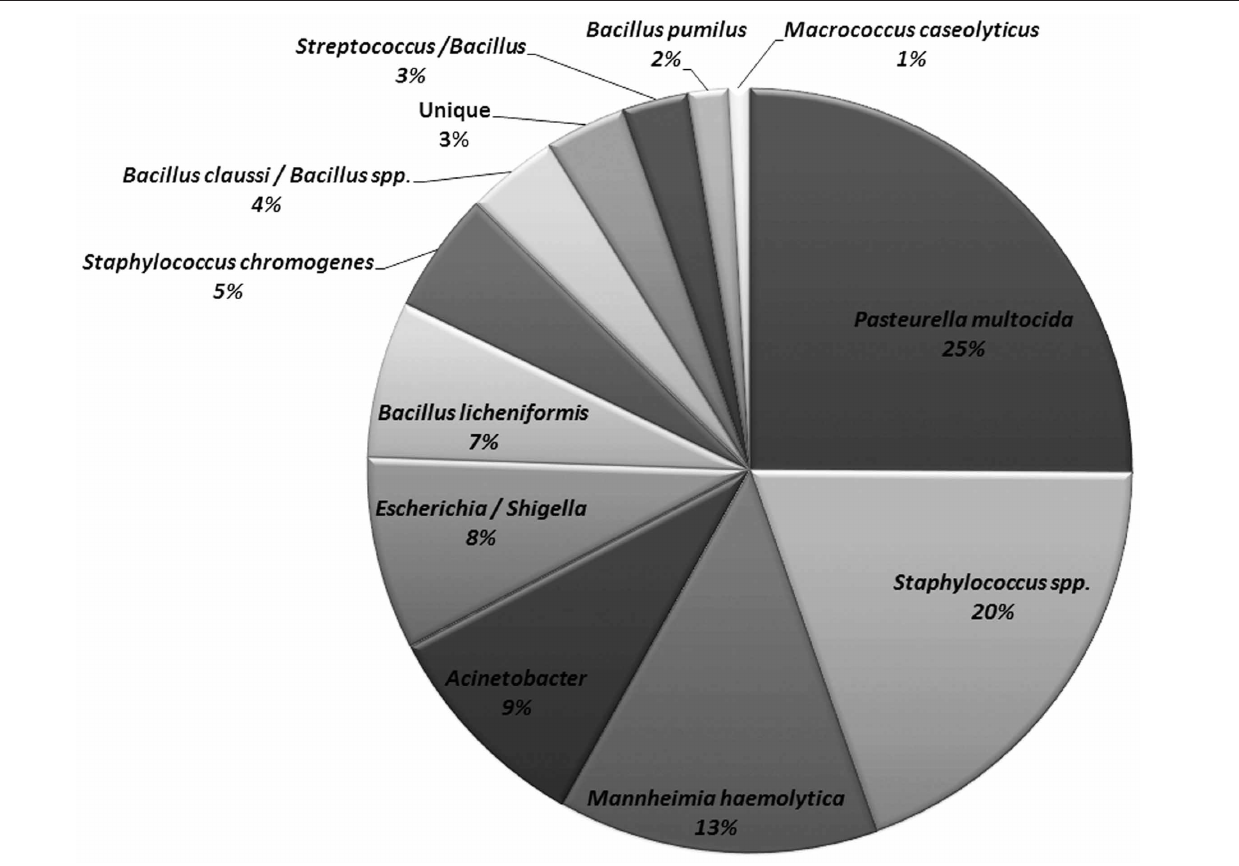
FIGURE 4 | Relative abundance of bacitracin resistant bacterial species isolated from nasopharynx over 28-days sampling period. One representative of each morphology per animal per sampling event were used to determine bacterial species prevalence ( n = 466).